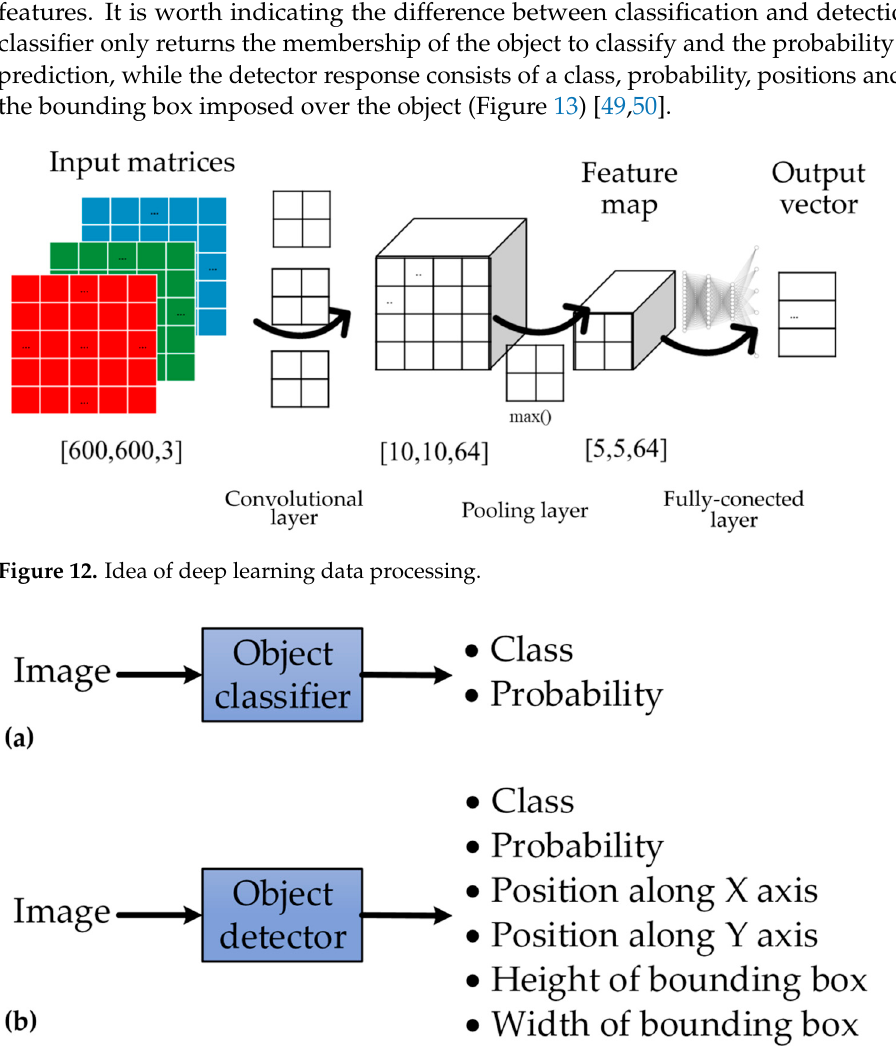
Figure 13. Comparison between classifier and detector: ( a ) inputs and outputs of object classifier; ( b ) inputs and outputs of object detector.